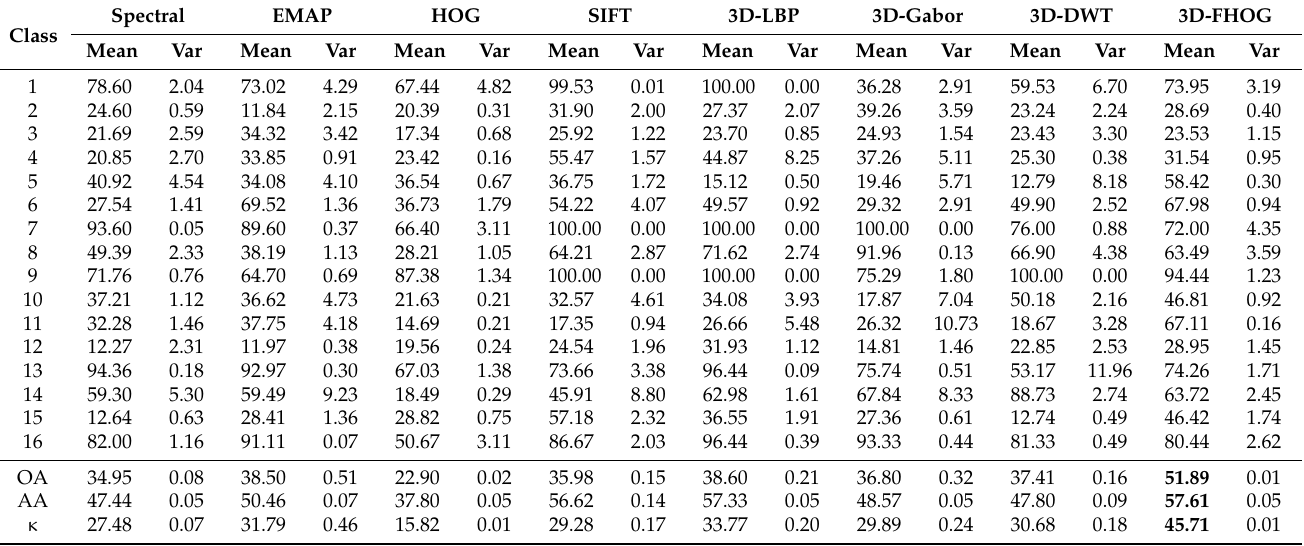
Table 5. Classification results (%) for Spectral, EMAP, HOG, SIFT, 3D-LBP, 3D-Gabor, 3D-DWT,